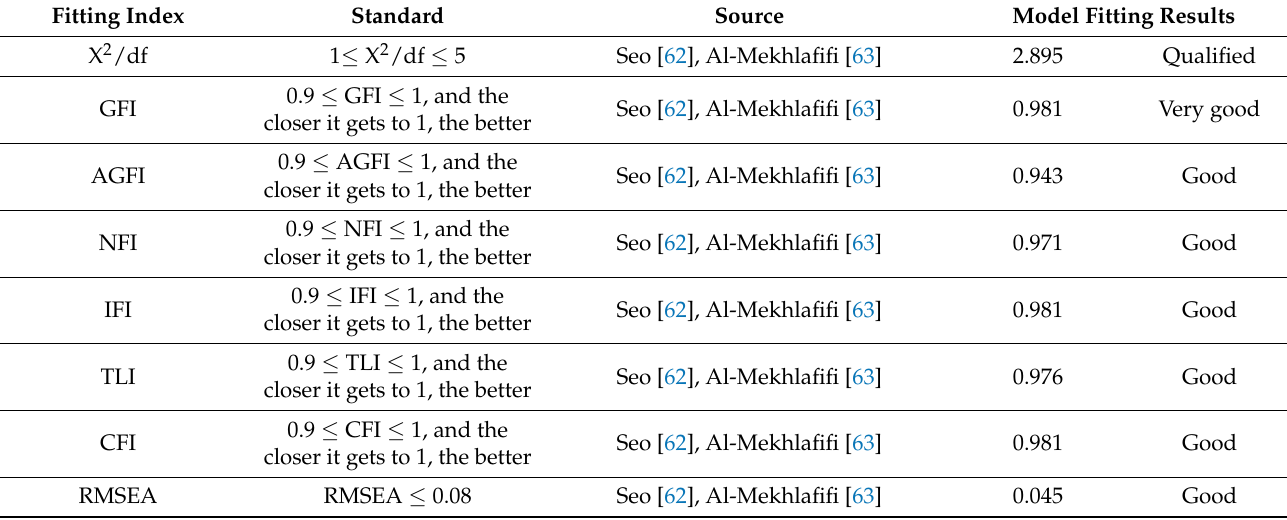
Table 6. Model fitting index evaluation criteria and model fitting